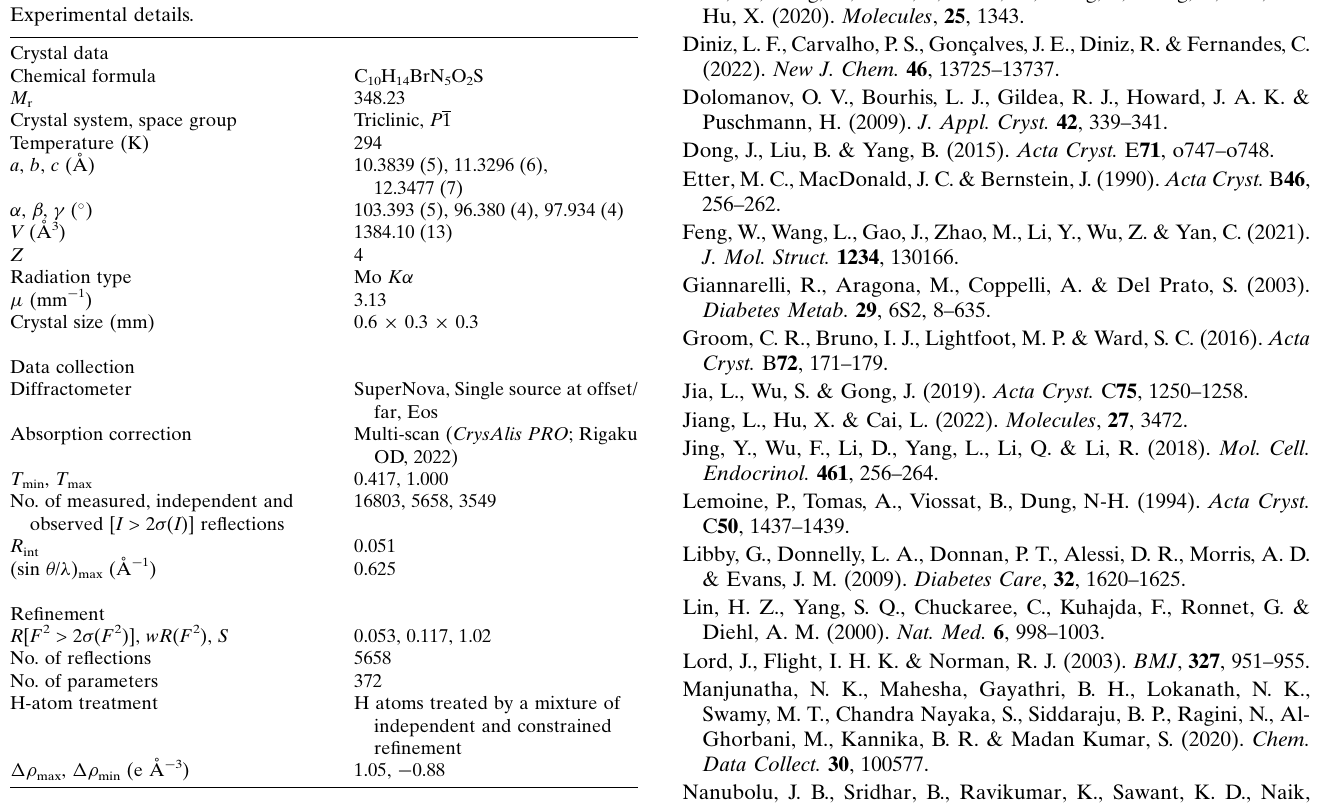
refined freely with U (H) values assigned as 1.2 U of the iso eq parent atoms. The occupancy factors of hydrogen atoms H11 and H15 B (molecule A ), and H30 and H34 B (molecule B ) involved in intramolecular hydrogen bonds converged during refinement to 0.85 (4) for H15 B and H34 B , and 0.15 (4) for H11 and H30.